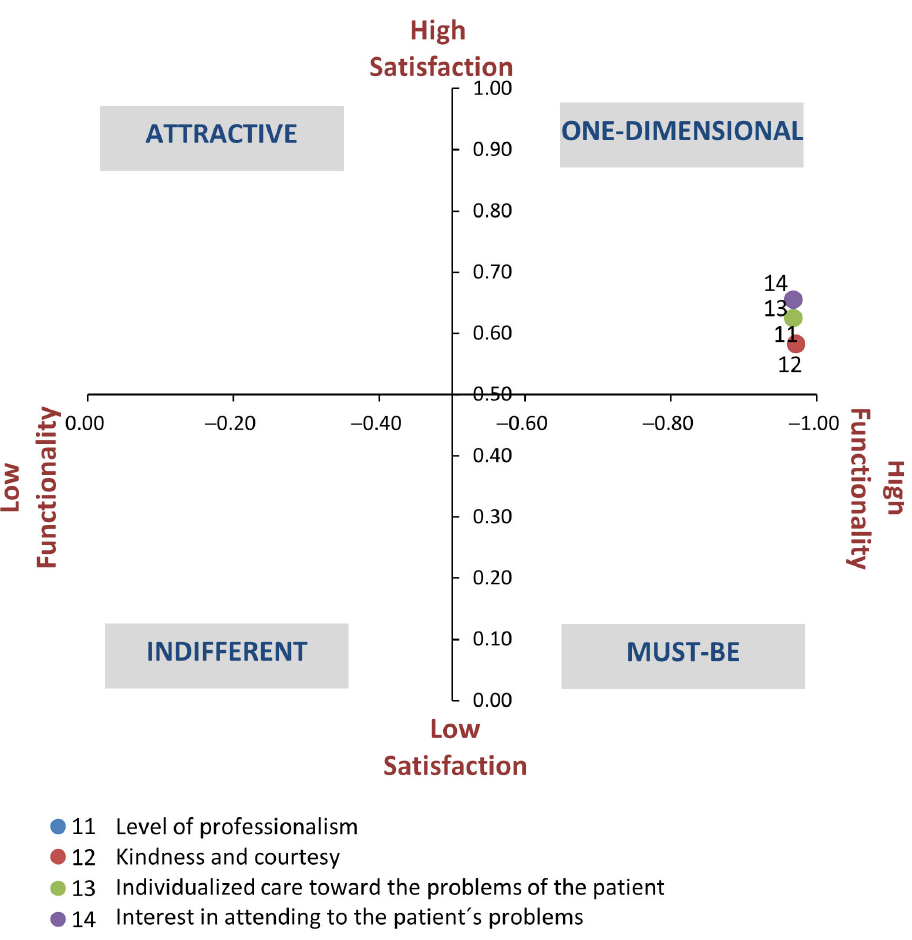
Figure 3. Classification of the attributes of the non-healthcare personnel